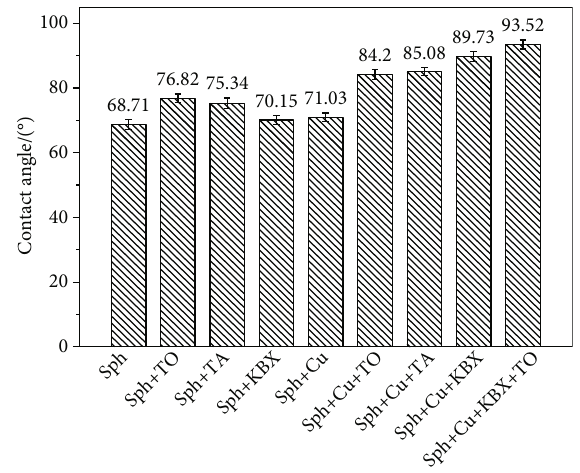
Figure 8: Contact angle of sphalerite treated with di ff erent fl otation reagents ( pH = 7 : 3 ; TO: 10 mg/L; TA: 10mg/L; CuSO KBX: 10